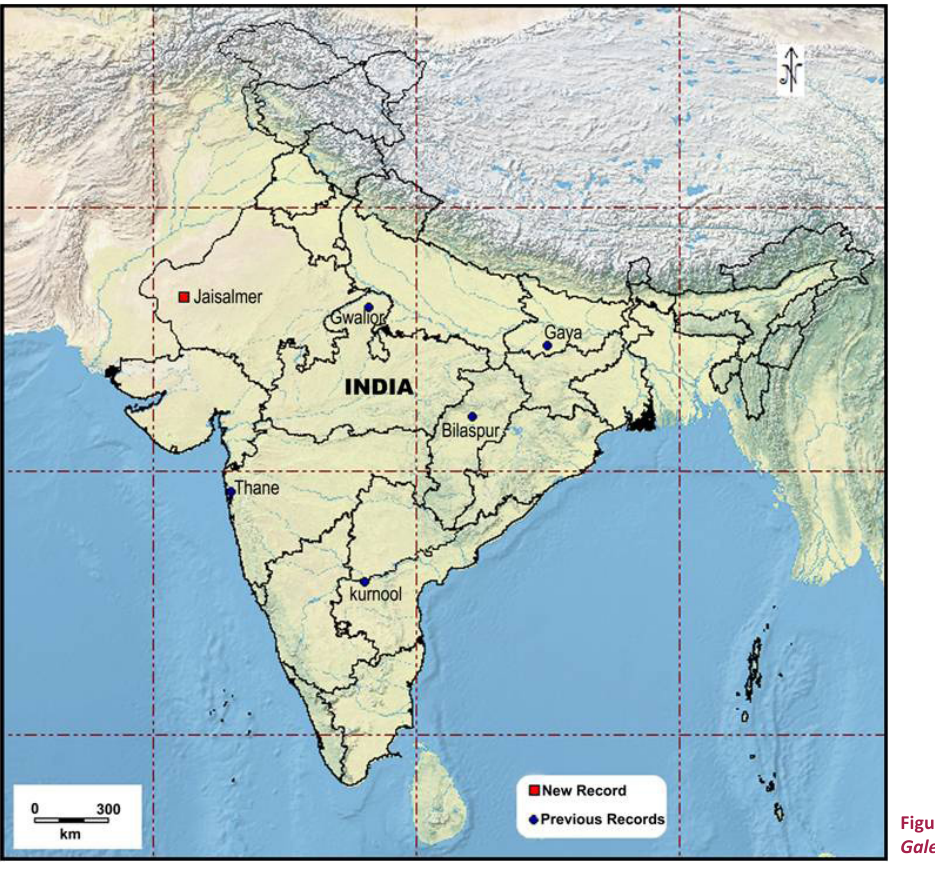
Figure 1. Distribution records of Galeodes indicus Pocock, 1900